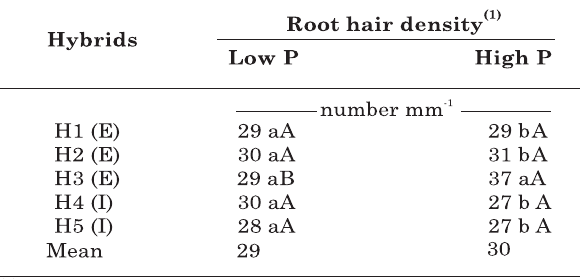
Table 4. Root hair density of maize hybrids grown at low and high soil P levels